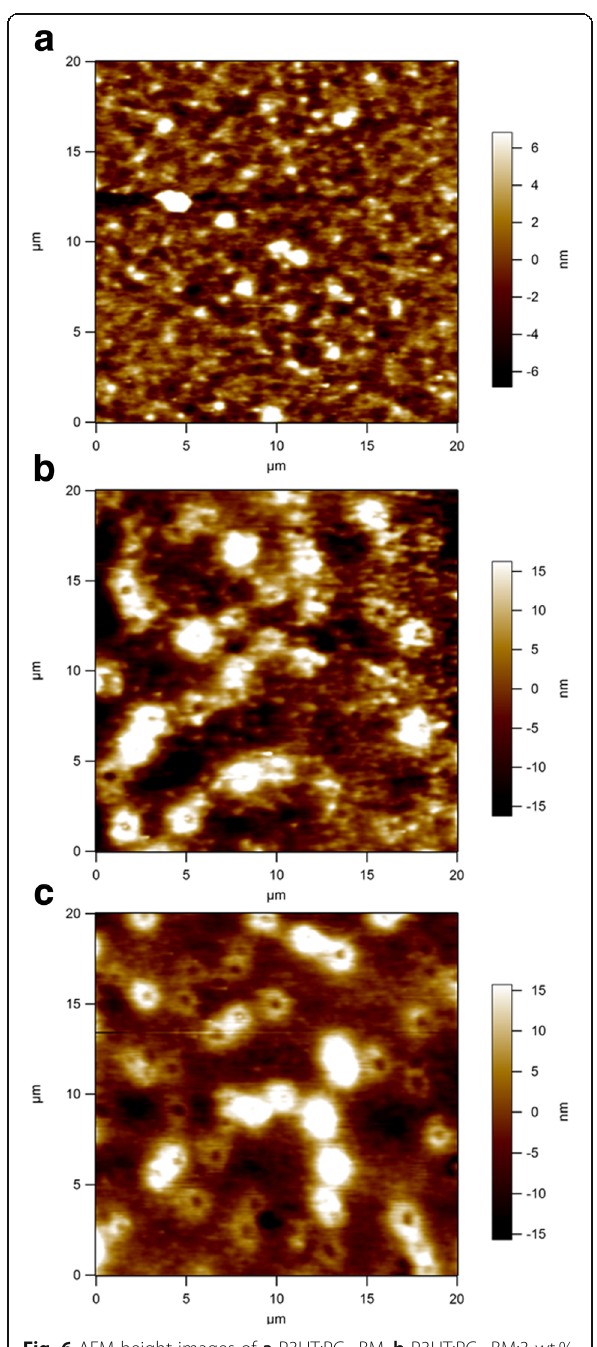
Fig. 6 AFM height images of a P3HT:PC 61 BM, b P3HT:PC 61 BM:3 wt.% CdS, and c P3HT:PC 61 BM:3 wt.% Sb 2 S 3 films on ITO